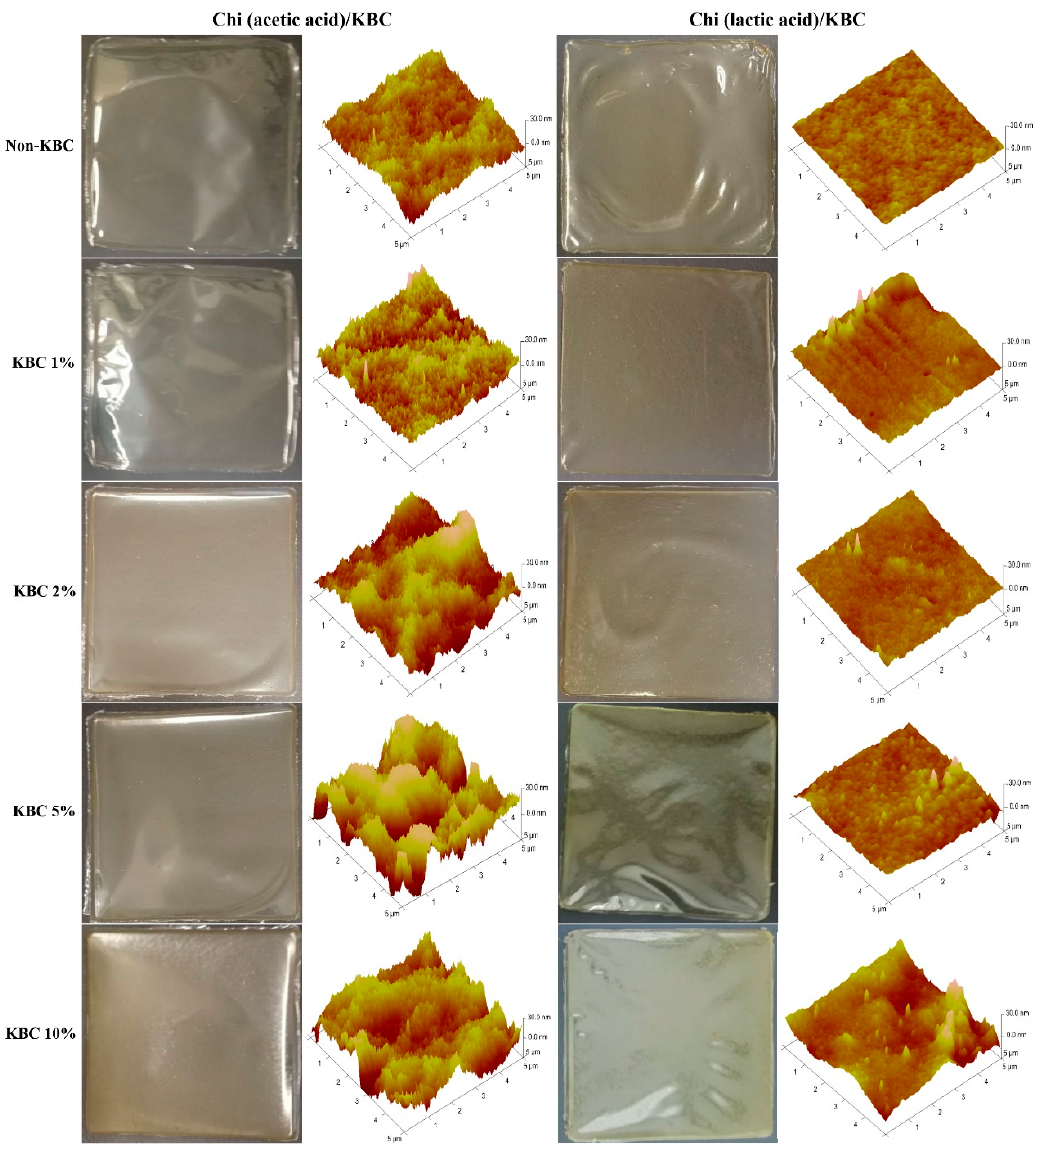
Figure 2. Physical appearance and AFM topography of modified Chi films at various concentrations of KBC.